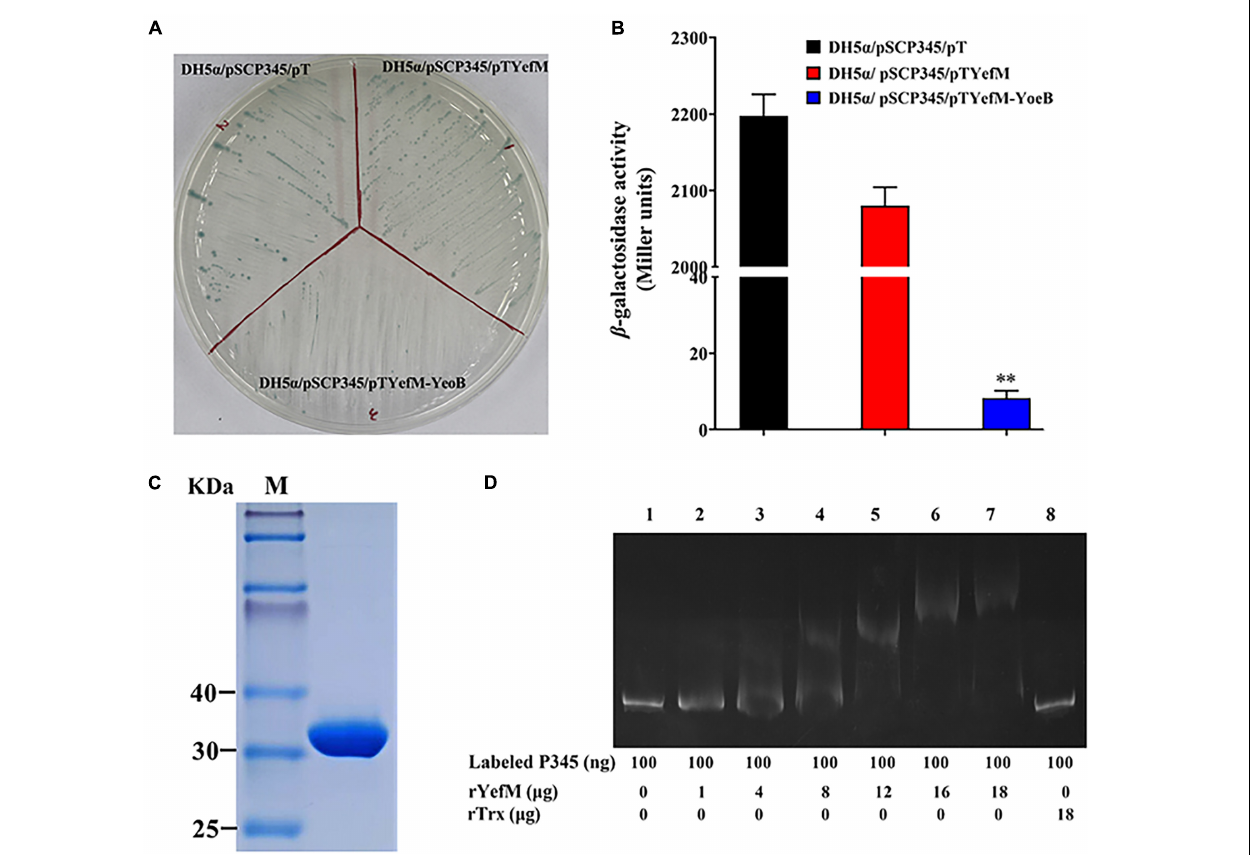
FIGURE 7 | Expression of yefMyeoB was regulated by YefM and YefM/YeoB. (A) DH5 α /pSCP345 / pT, DH5 α /pSCP345 / pTYefM, and DH5 α /pSCP345 / pTYefM-YeoB were streaked and cultured on LB plates with X-gal, kanamycin, and ampicillin. (B) The β -galactosidase activities of DH5 α /pSCP345 / pT, DH5 α /pSCP345 / pTYefM, and DH5 α /pSCP345 / pTYefM-YeoB was determined and shown by Miller units. Data are presented as the means ± SEMs ( N = 3). N, the number of times the experiment was performed. ∗∗ P < 0.01. (C) Purified rYefM was analyzed by SDS-PAGE. (D) Interaction between YefM and the speculative promoter regions of yefMyeoB . An electrophoresis mobility shift assay (EMSA) was performed in binding buffer containing rYefM, rTrx (control), carboxyfuorescein-labeled P345, and the speculative promoter regions (P345) of yefMyeoB . The negative control